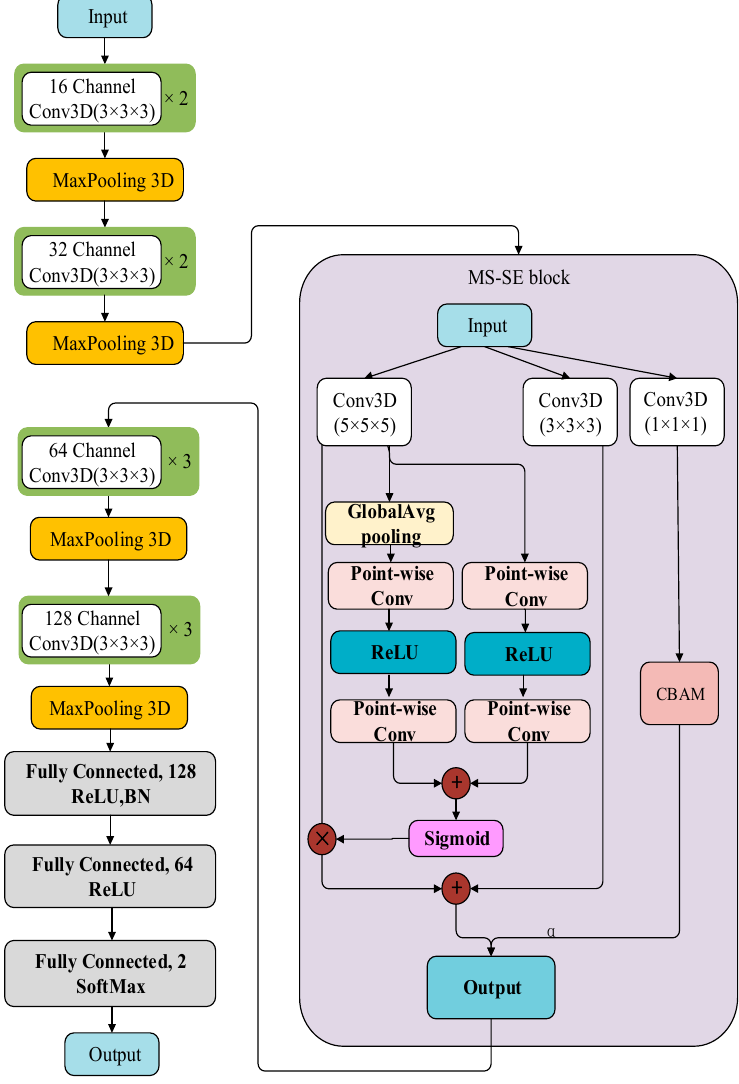
Figure 4. Structure of the improved VoxCNN